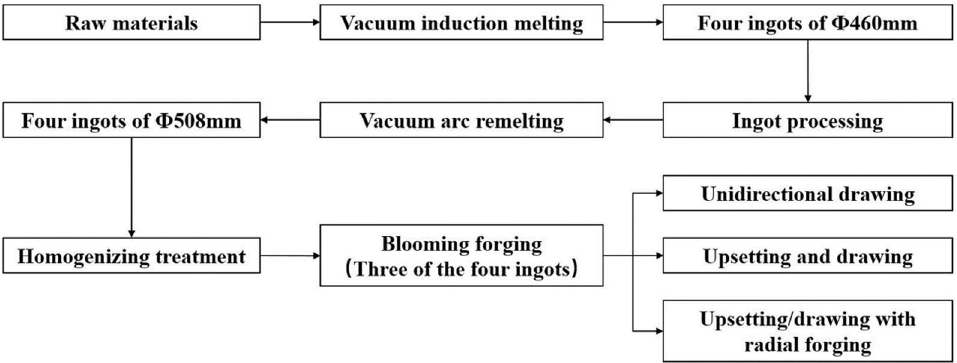
Figure 1. Roadmaps of melting and hot working.